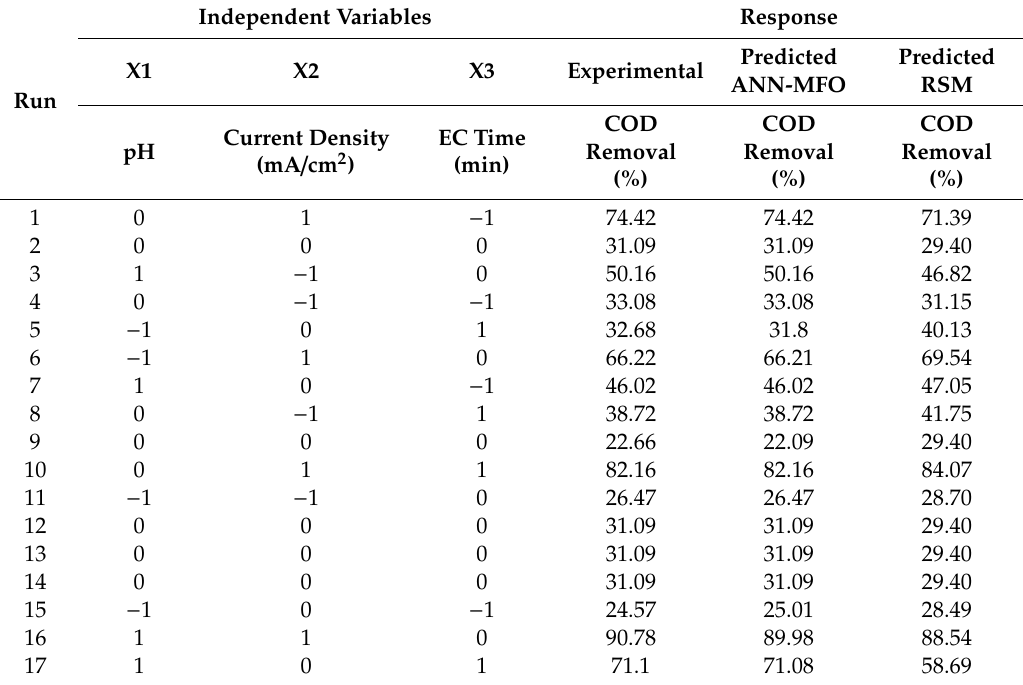
Table 6. Box–Behnken design, observed and predicted values concerning COD removal.